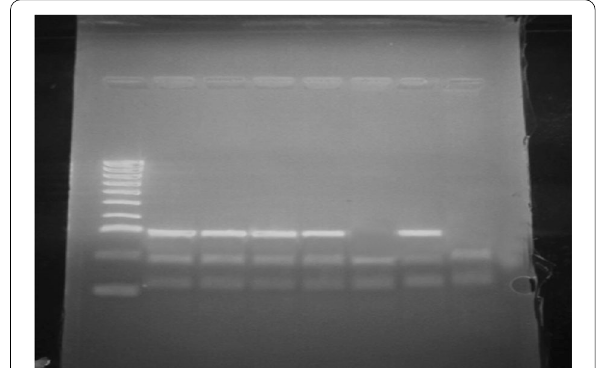
Fig. 3 Distribution of in IL2RA rs2104286 genotypes in diabetic patients and control samples. Genotyping of IL2RA rs2104286 genotypes from left: • Lane 1: DNA ladder 100bp. Band (A) at (288) bp Band (G) appears as two fragments. • Lanes 2, 3, 4, 5, and 7: Heterozygous (AG) where both A band and G band • Lane 6,and 8 :Homozygous (GG